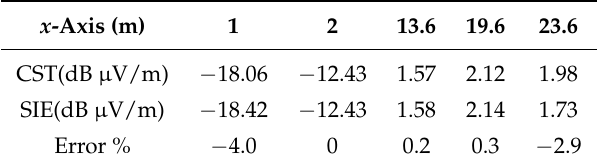
Table 1. Electric field in x -direction component at test point ( x ,0, − 60 ) .